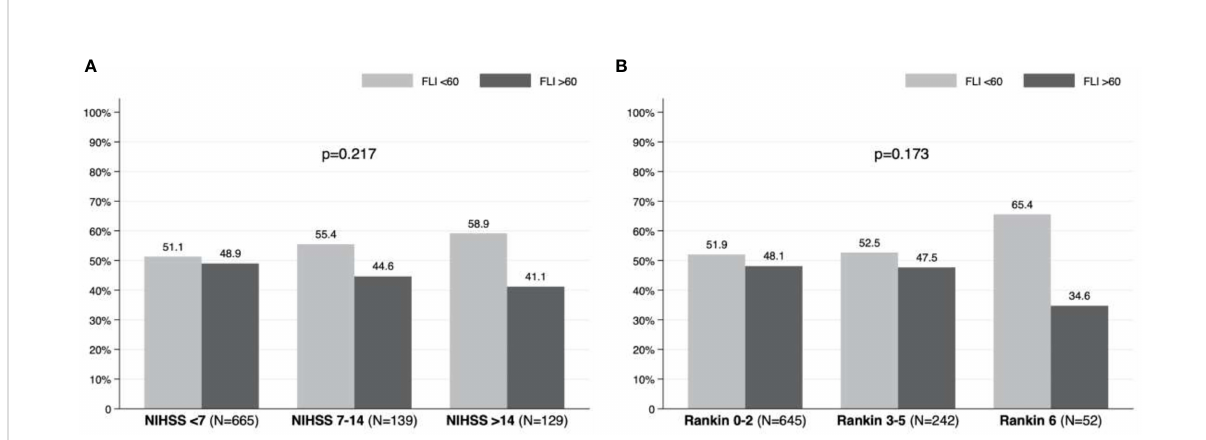
FIGURE 5 Prevalence of non-alcoholic fatty liver disease according to: (A) severity (NIHSS) and (B) prognosis (modi fi ed Rankin Scale) in patients with acute ischemic stroke.